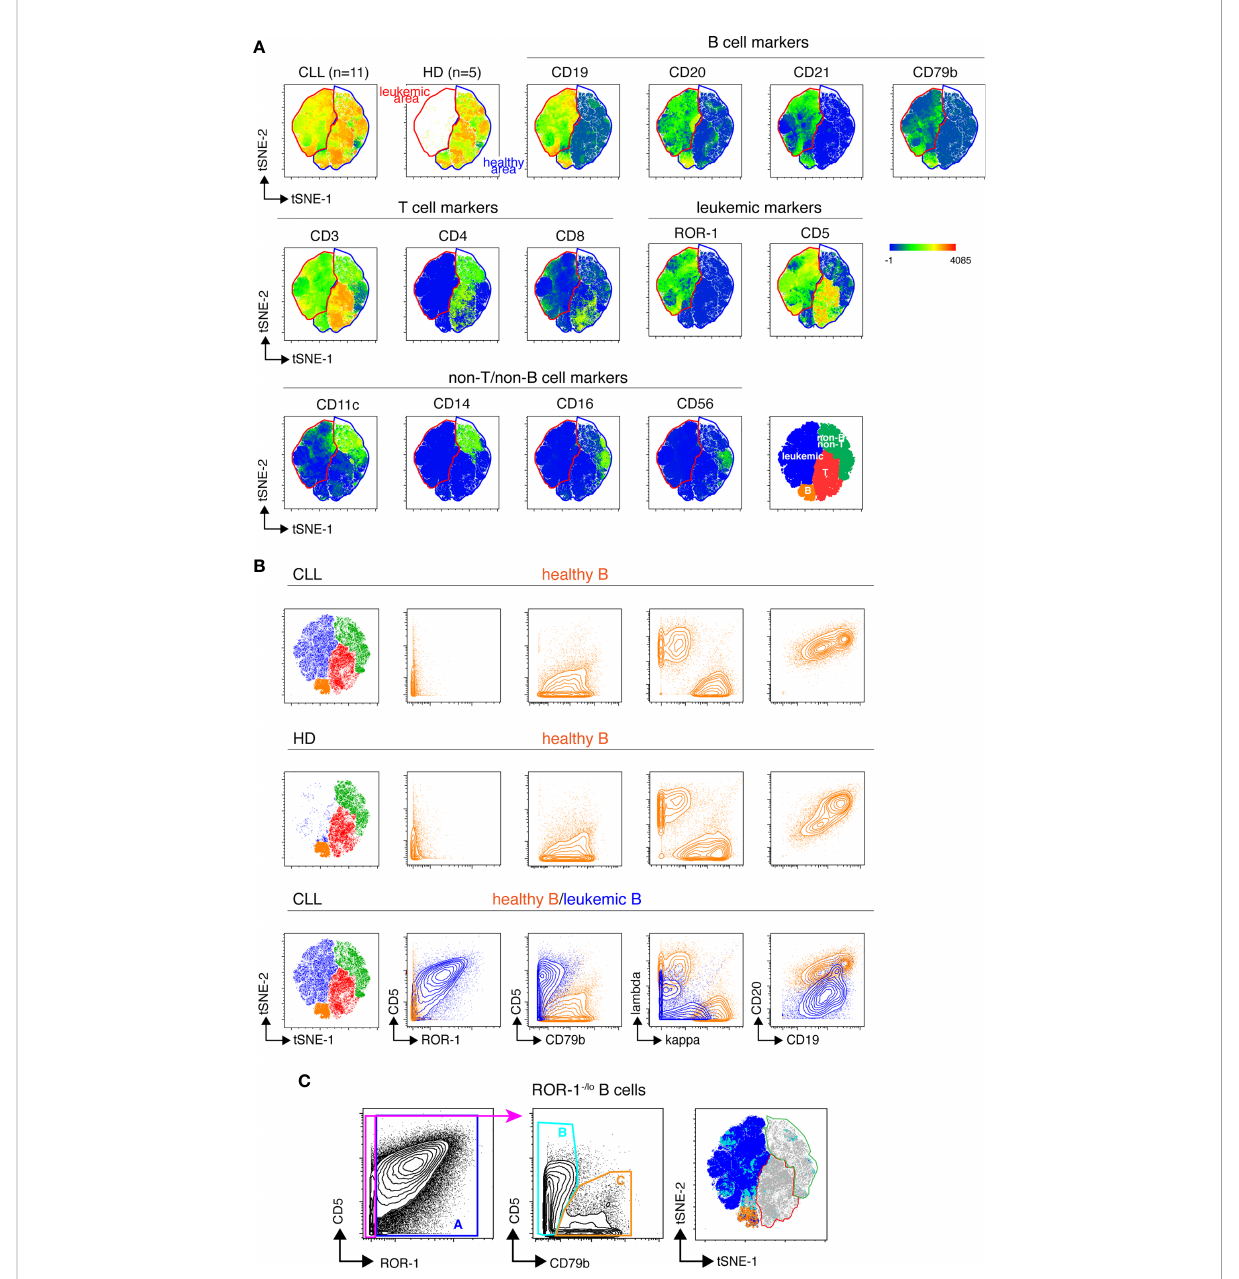
FIGURE 2 Unsupervised de fi nition of the non-malignant and leukemic B cell pools in CLL samples by mass cytometry. (A) Top row: CLL and HD t-SNE maps obtained after analysis of the PBMC from 11 CLL and 5 HD samples stained with the 24-marker panel (concatenated fi le including data from both the HD and CLL samples). The healthy B cell area, common to CLL and HD is gated in blue, the leukemic B cell area that appears only in the CLL samples is gated in red. Middle and lower row: marker expression shown as heat plots on the t-SNE map of concatenated CLL fi les. Bottom right: representation of the areas occupied on the t-SNE map by leukemic cells and healthy T, B and non-T non-B cells colored by cell-type assignments. (B) Validation of the leukemic and healthy areas. Expression of CD5, ROR-1, CD79b, Ig light chains, CD19 and CD20 by healthy B cells from CLL patients (upper row) or from HD (middle row) manually-gated on the t-SNE maps of merged HD or-CLL samples. Lower row, overlay of non-malignant and leukemic B cells from the merged CLL samples. Note that Ig k and Ig l light chains are apparently co- expressed on leukemic B cells because the analysis is conducted on 11 CLL leukemic clones that individually express distinct Ig light chain isotypes. (C) Distribution of ROR-1 + and ROR-1 -/lo leukemic B cells within the leukemic and healthy B cell areas of the merged CLL t-SNE map. Left: ROR-1 + (population A) and ROR-1 -/lo B cells are manually gated on a ROR-1/CD5 bi-parameter plot. Middle: contour plots showing the pattern of CD79b and CD5 expression by ROR-1 -/lo B cells and the gating of CD79b lo /CD5 +/- B cells (pop B, pale blue) and CD79b hi /CD5 lo B cells (pop C, orange). Right: manually-gated populations (A – C) are overlayed onto the merged CLL t-SNE